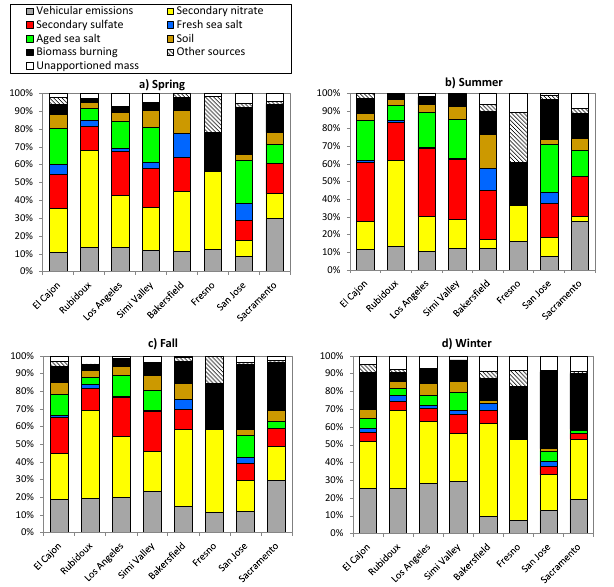
Figure 1 a-d. Seasonal variation in the percent contribution of identified sources to ambient PM 2.5 , by site.